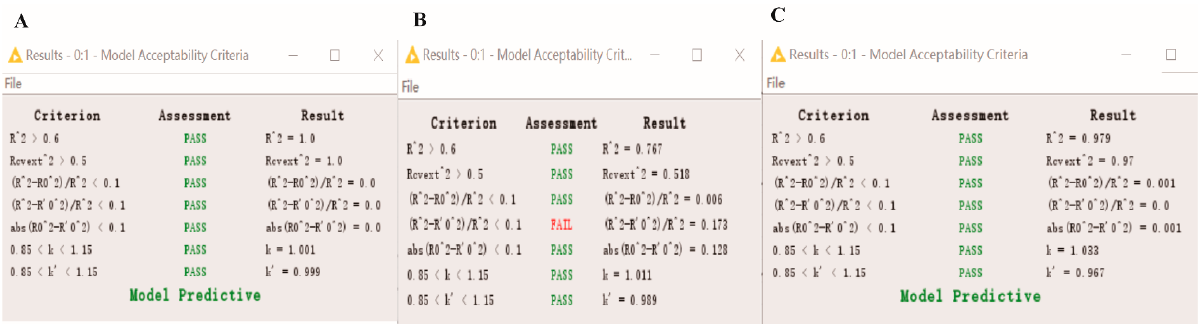
Figure 7. Enalos Model Acceptability Criteria KNIME node screenshot. ( A ): LD 50 ; ( B ): IC 50 ; ( C ): Nrf2.